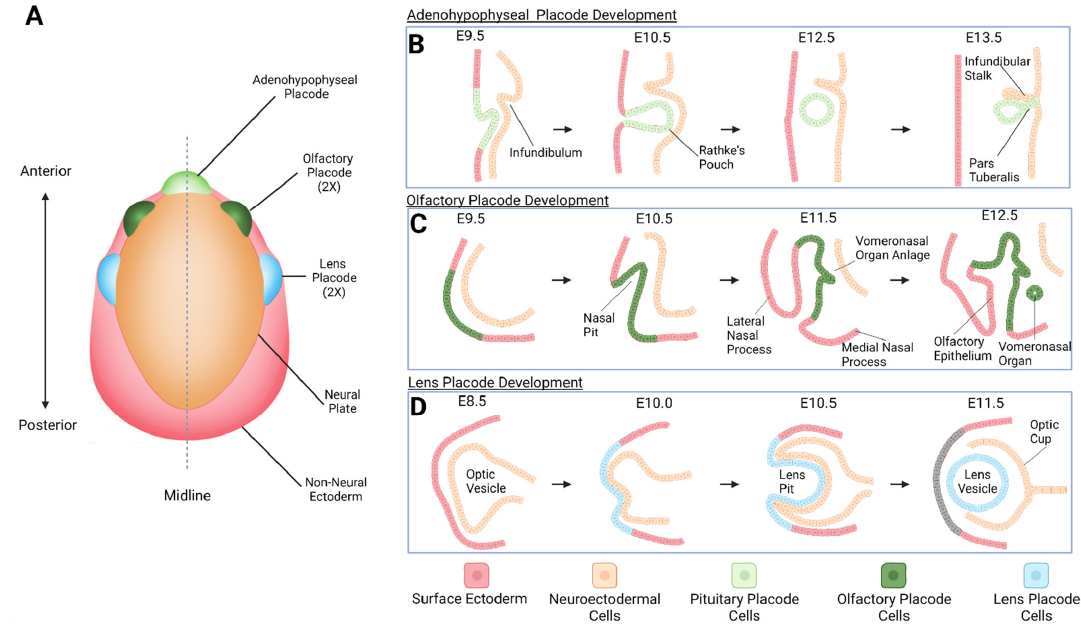
Figure 1. Formation of three anterior cranial placodes during mid-stage mouse embryogenesis. ( A ) Highly schematic visualization of future location of adenohypophyseal, olfactory, and lens placodes relative to the neural tube and its anterior/posterior patterning at the E8.0 mouse embryo. Regarding the eye and lens formation, note that the eye field is already formed within the anterior subregion of the neural plate [30] (not shown), and undergoes its symmetric division, later forming a symmet- ric pair of optic vesicles (see panel D). ( B ) Adenohypophyseal (pituitary) gland development from E9.5 via Rathke’s pouch [31] to E13.5, forming the infundibular stalk and the pars tuberalis [32]. ( C ) Olfactory placode development from E9.5 to E12.5, forming the vomeronasal organ [33]. ( D ) Lens placode development from E8.5 to E11.5, forming the lens vesicle [34]. The prospective corneal epi- thelium formed after the separation of the lens vesicle from the surface ectoderm is highlighted in gray. Note that for simplification, neural crest cells including periocular mesenchymal cells are not shown, but they are generally located in the space between the neuroectoderm and surface ecto- derm. For additional details, see https://syllabus.med.unc.edu/ for ultrastructural images of mouse eye development between these stages. The formation of both lens and olfactory placodes requires temporally regulated BMP signaling [35–37]. In addition, FGF signaling in lens progenitor cell formation pre- vents the formation of the alternate epidermal cell fate [36]. Nevertheless, given the com- plexity of FGF signaling at the neural plate/neural fold stage [30,38], there is no single or combined gene loss-of-function experiments including individual FGF receptors, FGFs, and other components of this pathway that abrogate lens placode formation. A subse- quent reciprocal invagination of the non-neurogenic lens placode and neuroectoderm-de- rived optic vesicle generates the earliest 3D eye primordium, comprised of the lens vesicle and optic cup [28,30,34]. These eye primordia are surrounded by periocular mesenchymal cells, required subsequently for anterior segment morphogenesis [39–44] and covered by the surface ectoderm, giving rise to the corneal epithelium [45]. At its anterior portion, the polarized lens vesicle is patterned by gradients of BMP, FGF, IGF, PDGF, and Wnt growth factors. Spatially regulated expression of these growth factor receptors [46–49] subse- quently forms the monolayer of the epithelium. The posterior portion of the lens vesicle undergoes cell cycle-exit coupled differentiation regulated by complex interactions be- tween BMP, FGF, and PDGF signaling [50–53] to generate the primary lens fiber cells. The